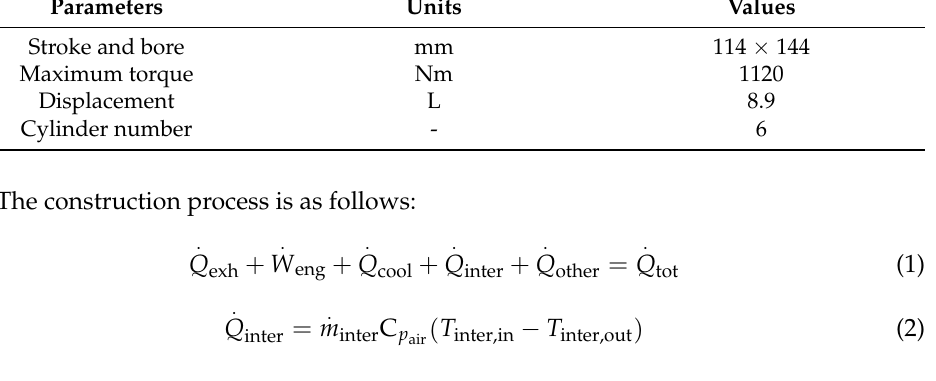
Table 3. Technical parameters of CNG engines. Parameters Units Values